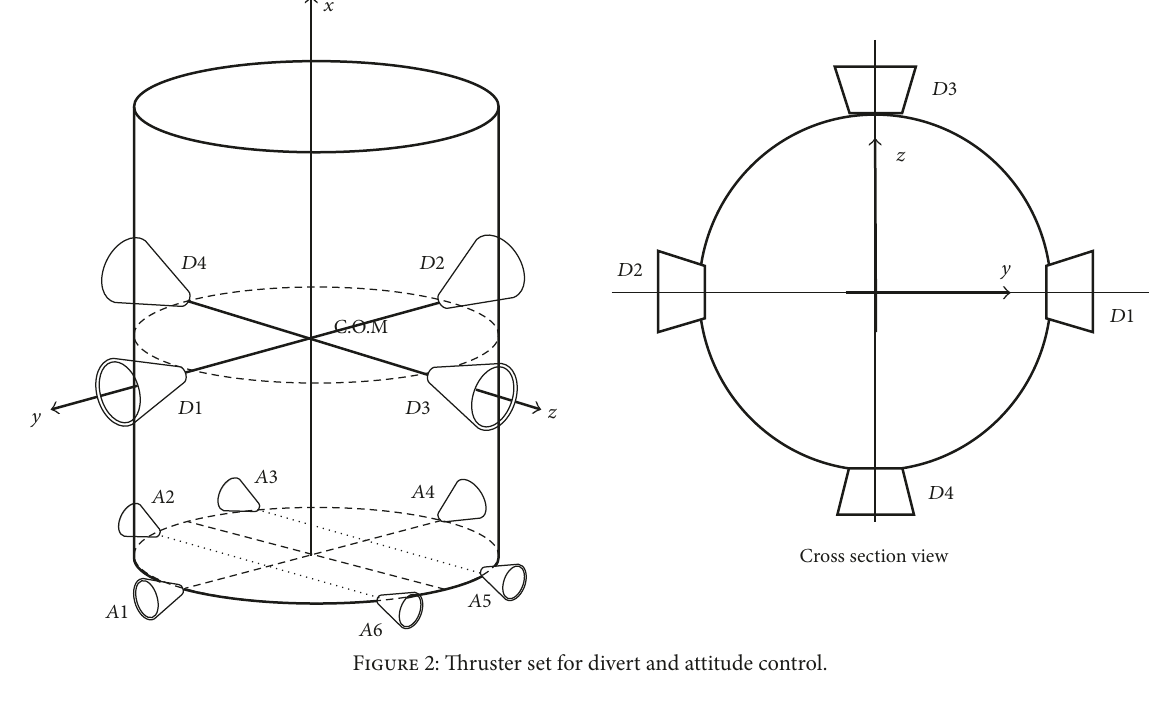
Figure 2: Thruster set for divert and attitude control.